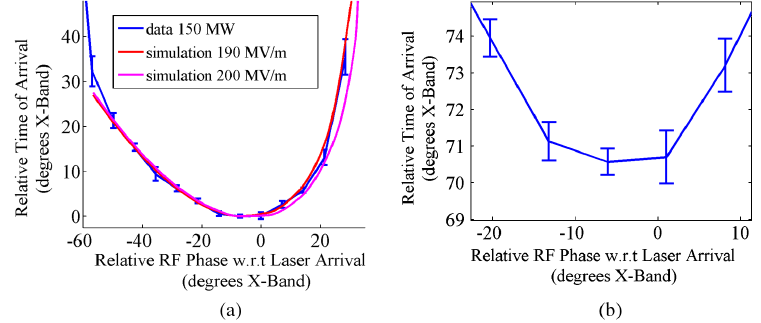
FIG. 17. (a) RTOA measurements at 150 MW compared with simulations at gradients of 190 MV = m and 200 MV = m, (b) zoom-in of the data near the RTOA minimum. RMS fluctuations were calculated using the 50 sample